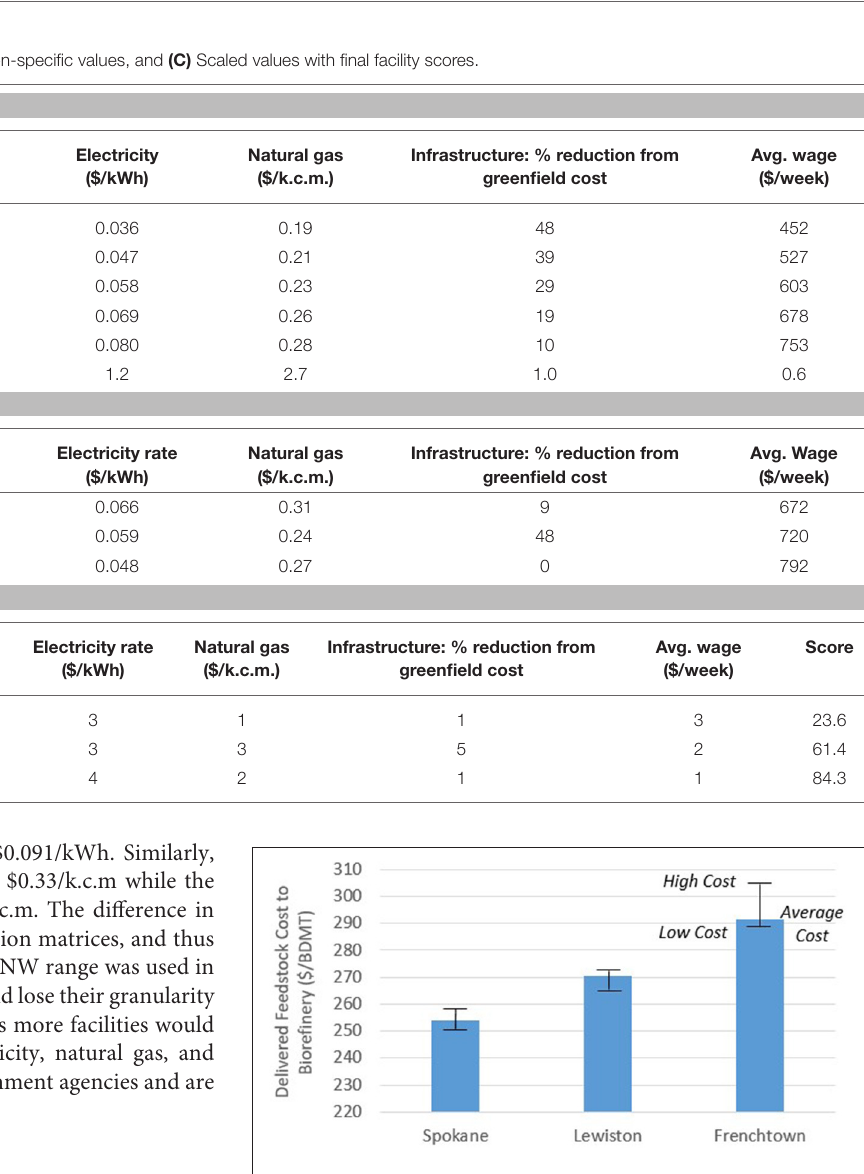
FIGURE 4 | Biomass sensitivity analysis with low-cost, average, and high-cost